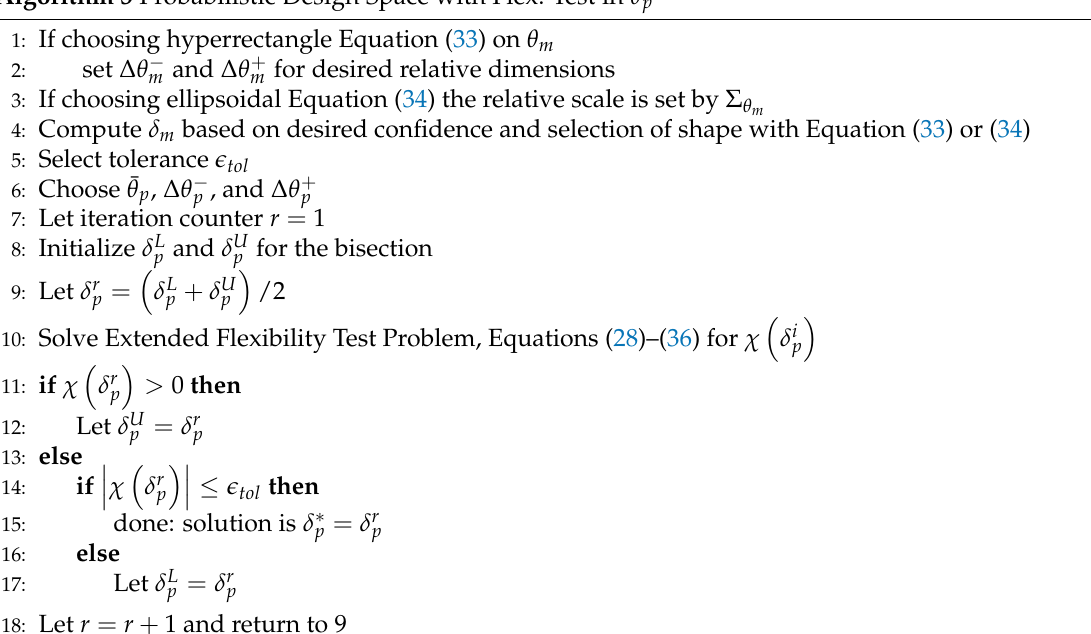
Algorithm 3 Probabilistic Design Space with Flex. Test in θ